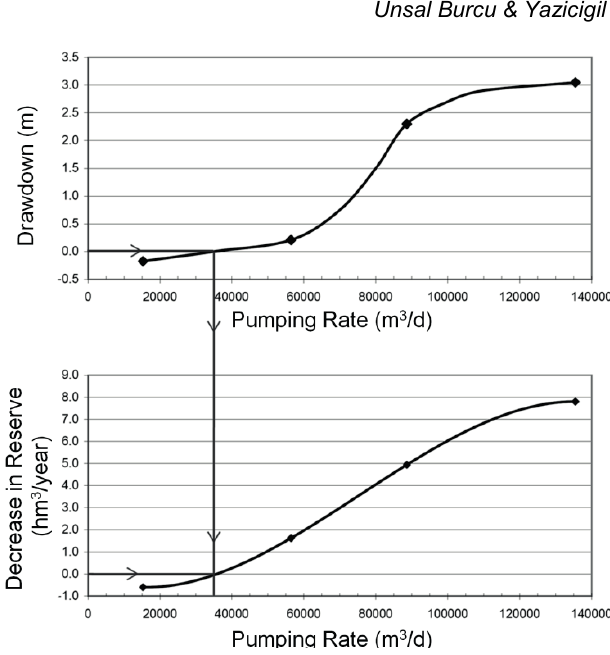
Fig. 3 Trade-off